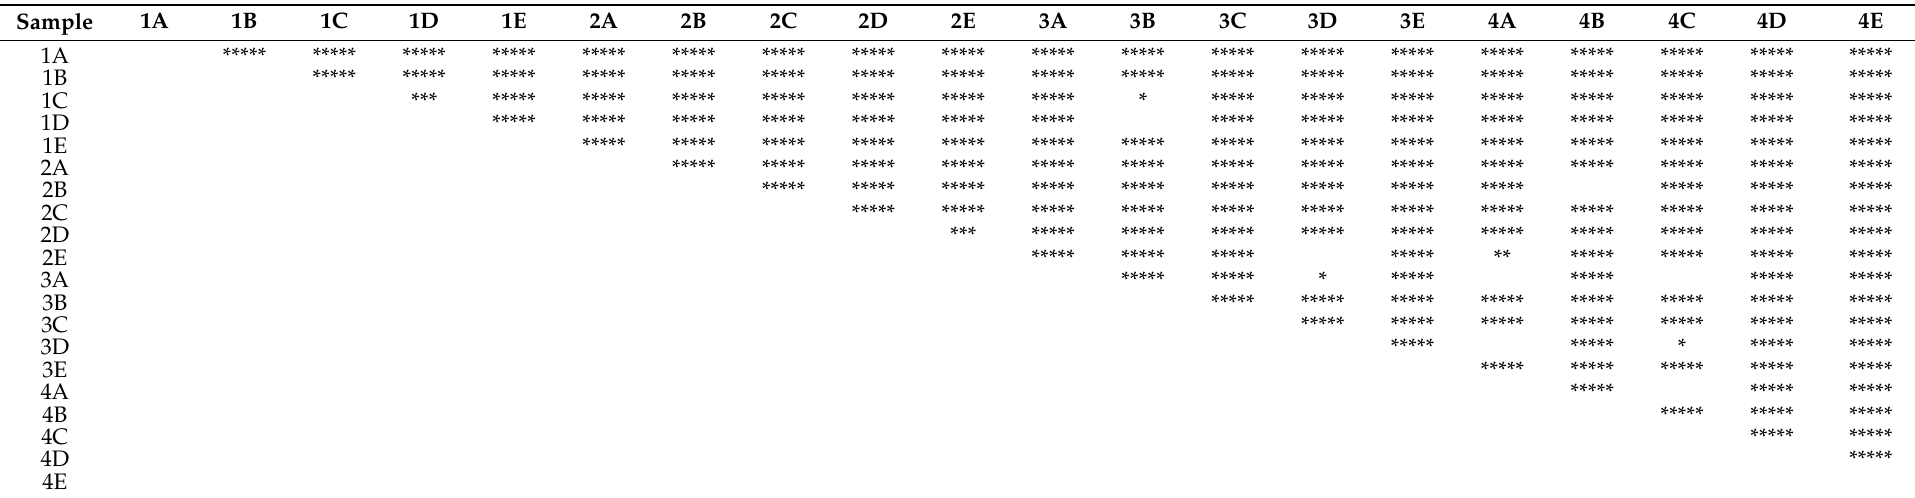
Table 8. Differences among the concentration of histamine in yellowfin tuna samples from ANOVA and the Tukey